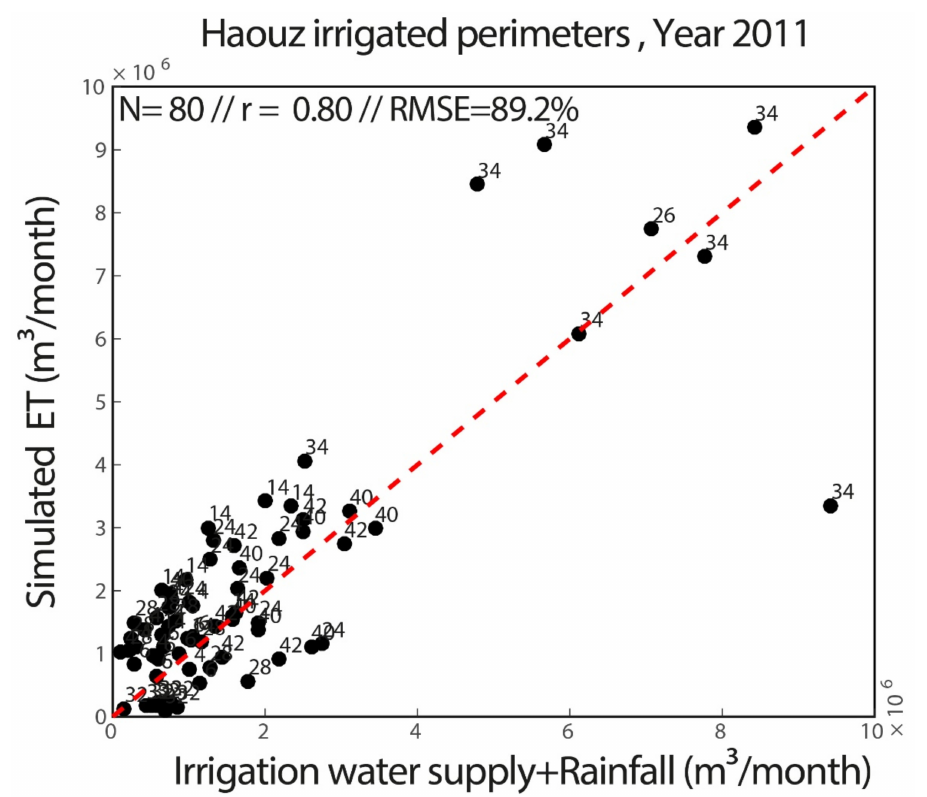
Figure 6. Confrontations between monthly evapotranspiration cumulated at the perimeter scale and the monthly water supply composed of irrigation + CRU rainfall throughout all these perimeters during the year 2011. The number near each dot corresponds to the index of irrigated area presented in Table